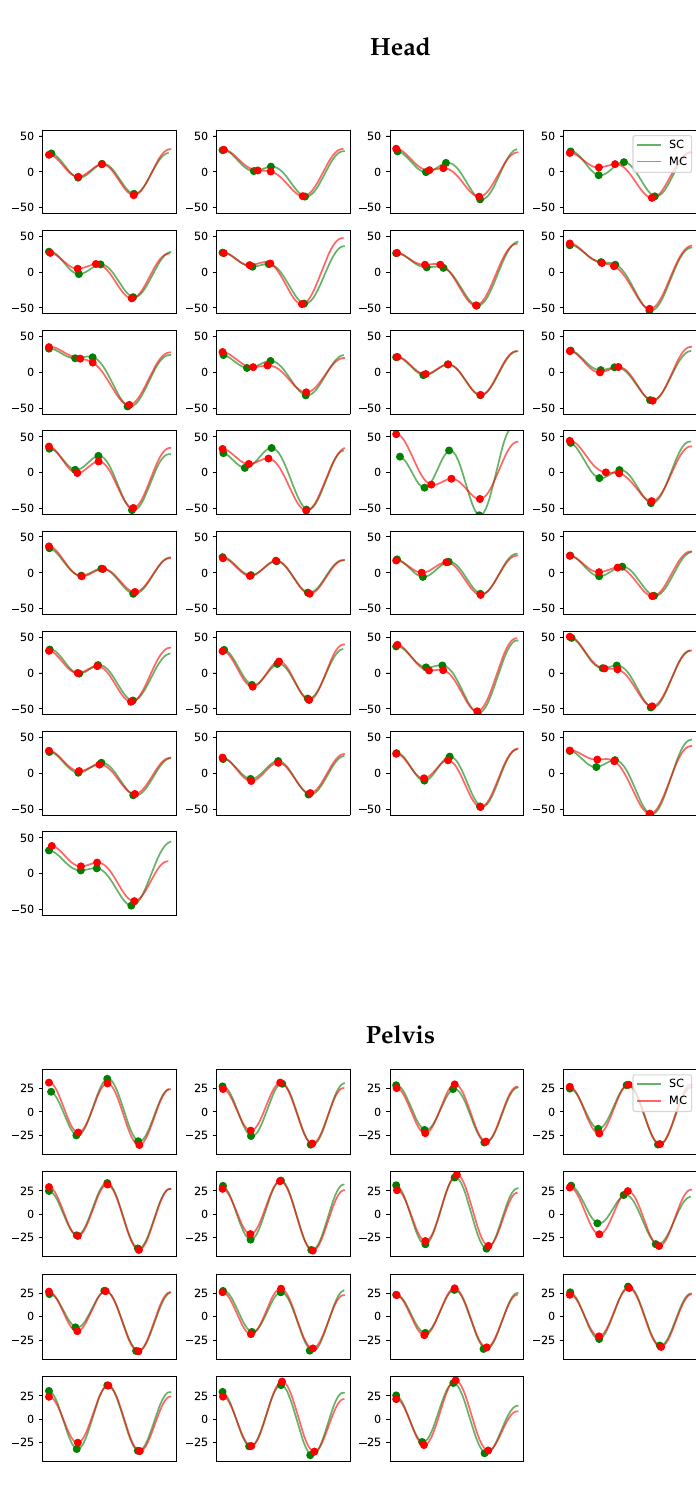
Figure A8. Vertical displacement signals per stride for the head and pelvis for horse 9. Each subplot contains the matched stride segments for the single-camera markerless system (SC) in green and the multi-camera marker-based system (MC) in red. The y-axis shows the vertical displacement in millimeters. The four dots on each curve indicate the positions of the two peaks and two valleys extracted using the approach in Section